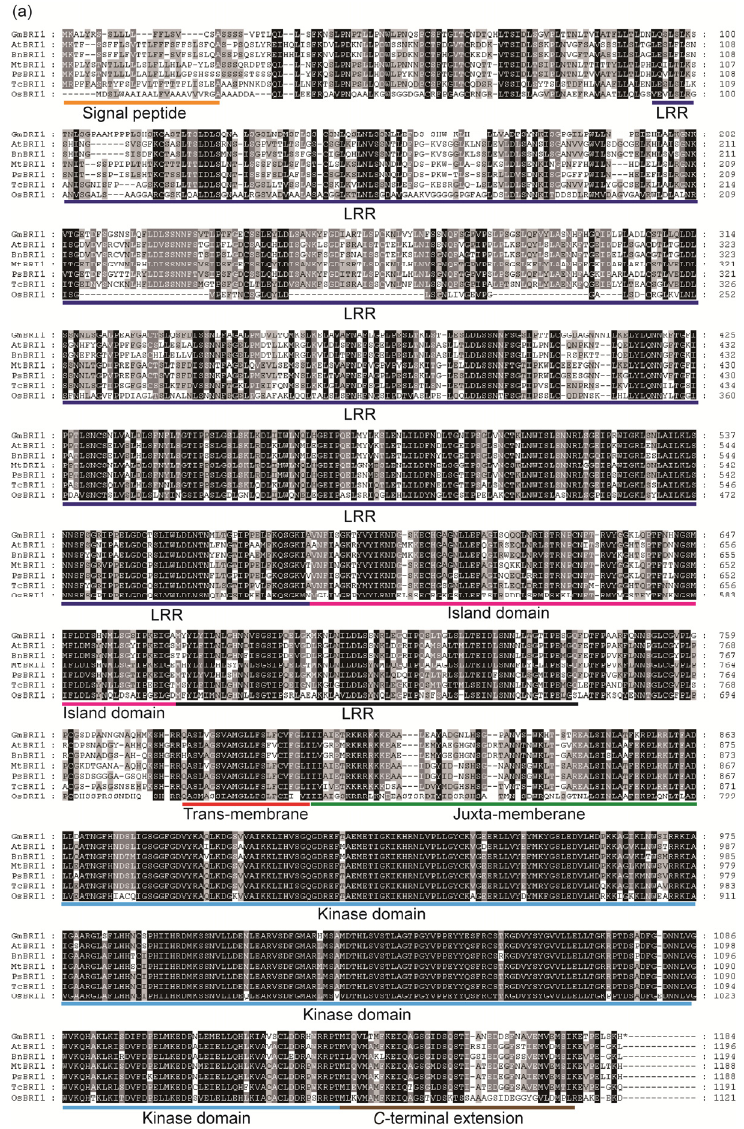
Figure 1. Characterization of GmBRI1 protein. ( a ) Multiple alignment of the deduced GmBRI1 protein with brassinosteroid insensitive (BRIs) from various species (At, Arabidopsis ; Bn, Brassica napus ; Mt, Medicago truncatula ; Ps, Pisum Sativum ; Tc, Theobroma cacao ; and Os, Oryza sativa ). The predicted functional domains are marked in the relative positions. The amino acid sequences were obtained from the NCBI protein database. The amino acid sequences that are identical in all seven molecules are shaded black, while sequences that are conserved in four to six species are shaded gray; and ( b ) Phylogenetic analysis of GmBRI1 and homologs from other organisms. A bootstrap consensus tree was generated using the neighbor-joining method in MEGA 5.02. The bootstrap values from 1000 bootstrap replicates are shown next to the branches. The accession numbers are as follows: GmBRI1, XP_003526839; PsBRI1,